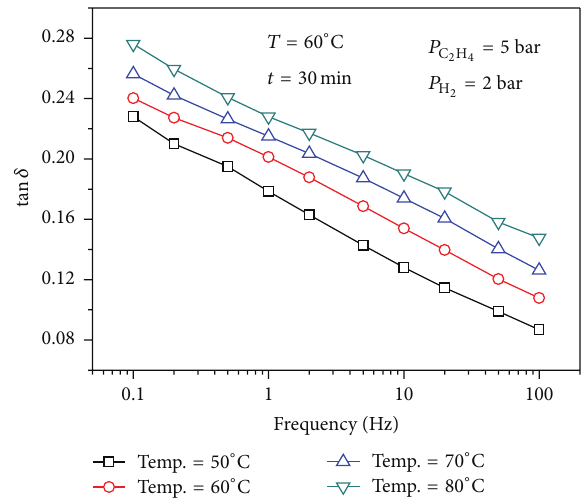
Figure 2: Dynamic temperature step/frequency sweep (tan 𝛿 ) for copolymer sample 2 synthesized at 𝑃 𝑇 temperature = 60 ∘ C, and 𝑡 polymerization